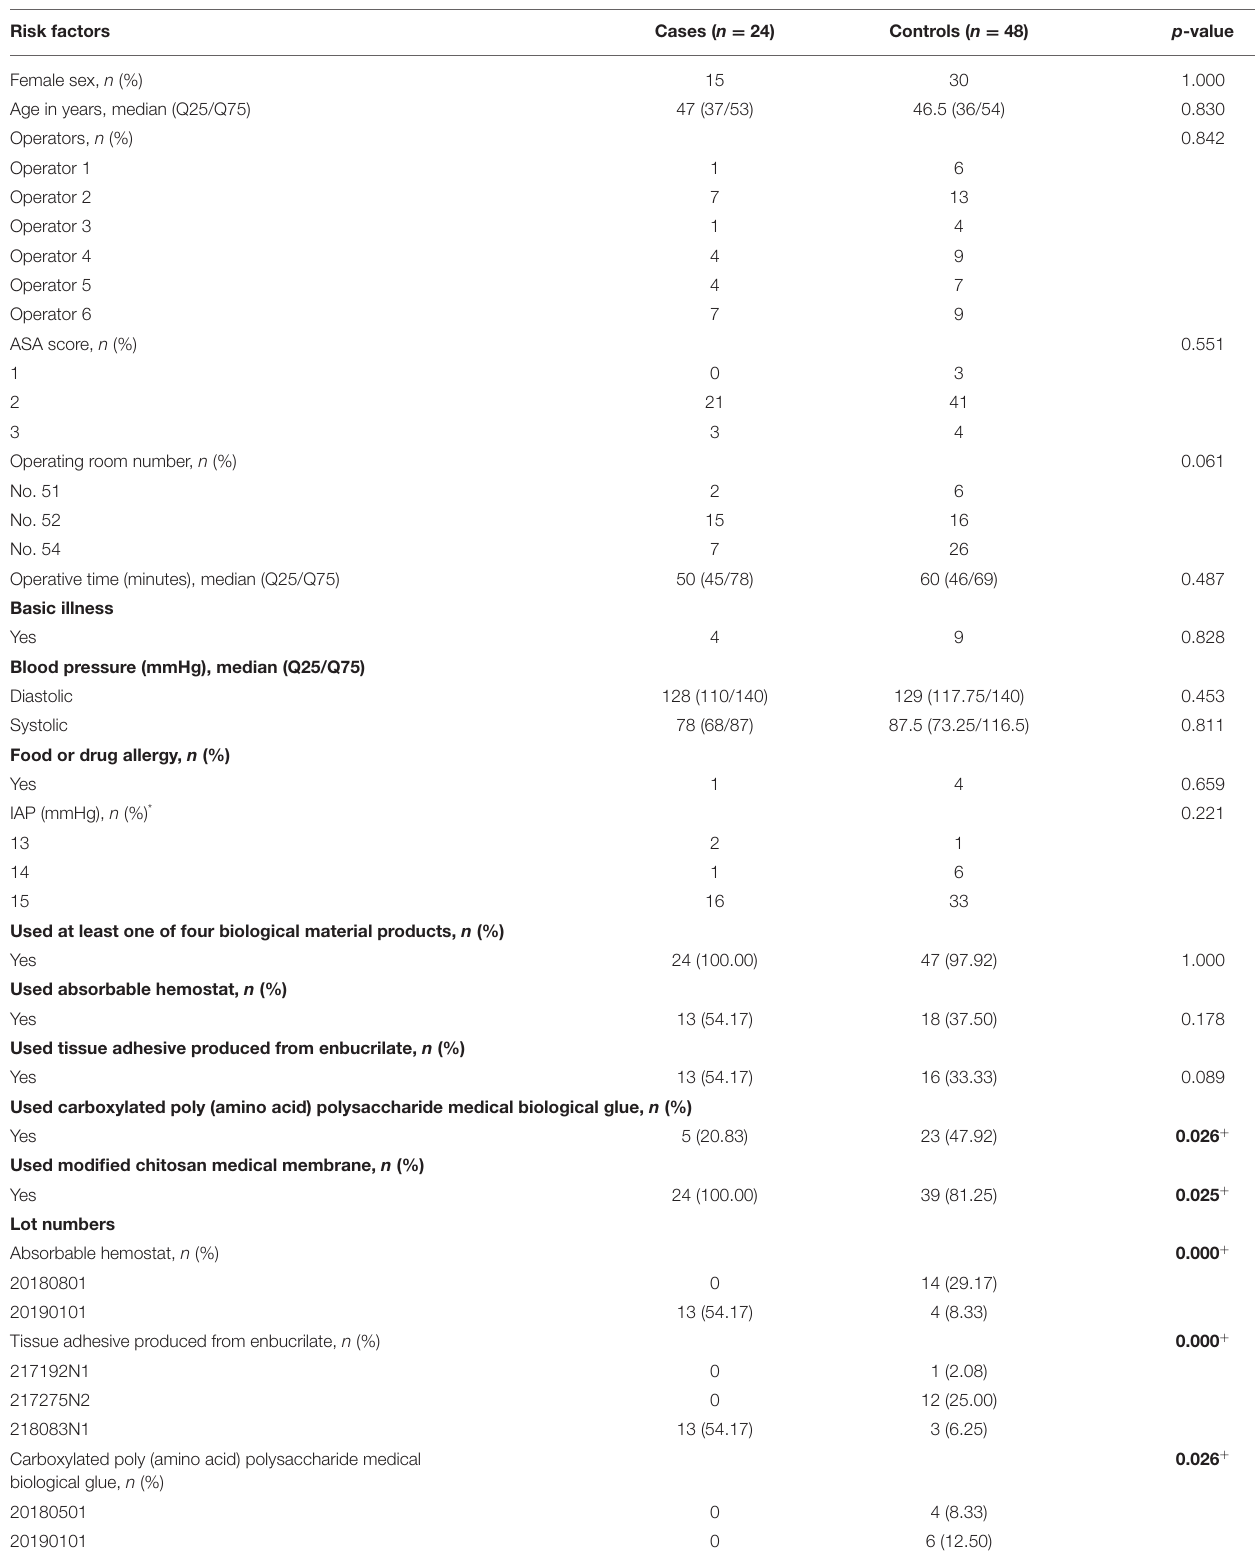
TABLE 2 | Risk factors in the case and control groups for binocular conjunctival congestion. Risk